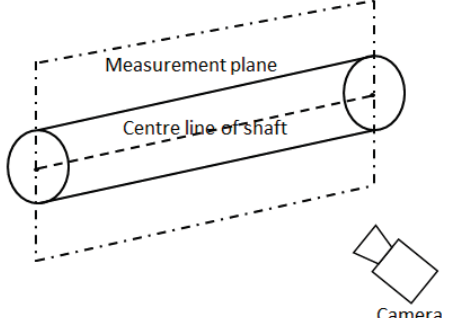
Figure 2. The orientations of the shaft and the measurement plane in 3D space (with permission from